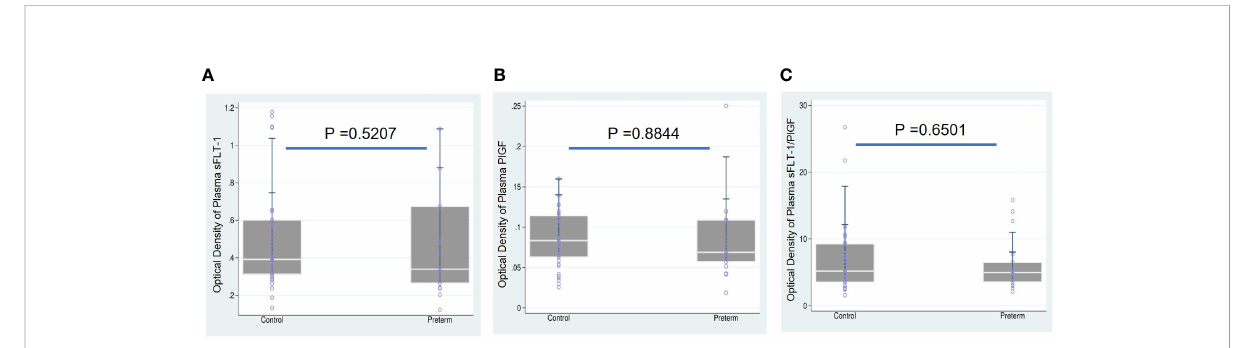
FIGURE 1 Boxplots overlaid with scatterplots showing median sFLT-1, PlGF, and sFLT1/PlGF ratio in maternal plasma, comparing preterm birth (PTB) and controls (Ctrl). (A) sFLT-1 in PTB (0.3385) vs. Ctrl (0.3918), (B) PlGF in PTB (0.0688) vs. Ctrl (0.0833), and (C) sFLT-1/PlGF ratio in PTB (4.9779) vs. Ctrl (5.2004) showed that sFLT-1, PIGF and sFLT-1/PlGF were not signi fi cant in compared to Ctrl groups.